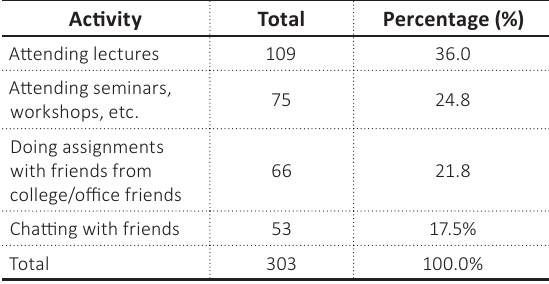
Table 1. Goodness-of-fit